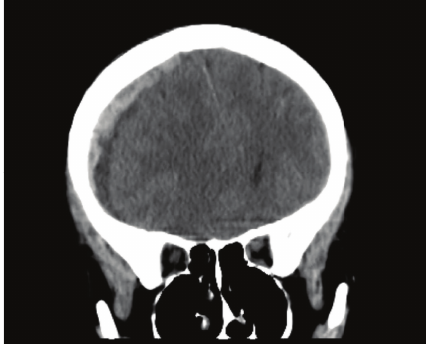
Figure 2: Computed tomography coronal image showing right subdural hematoma with midline